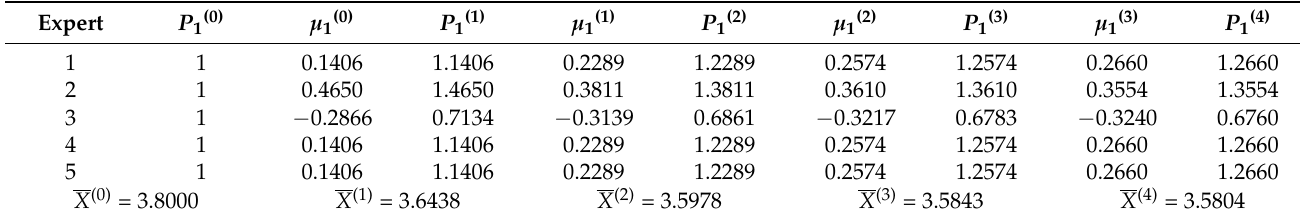
Table 5. Correction of adverse geology score.